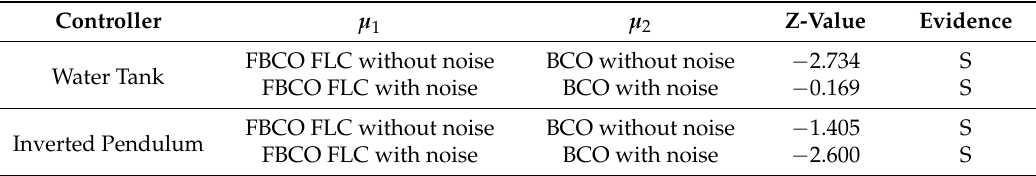
Table 15. Results for the statistical test with Fuzzy bee colony algorithm.